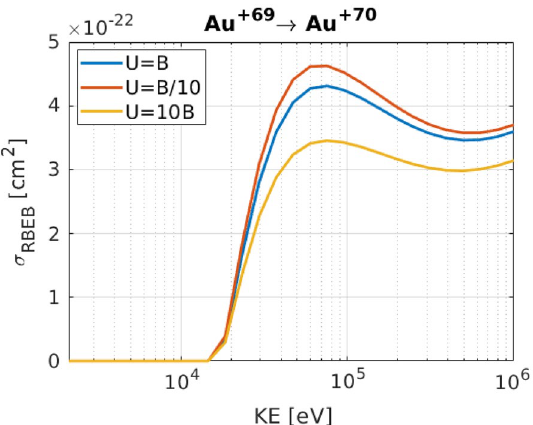
Figure 5. left: Cross sections of Au 69 → 70 transition for different U and B